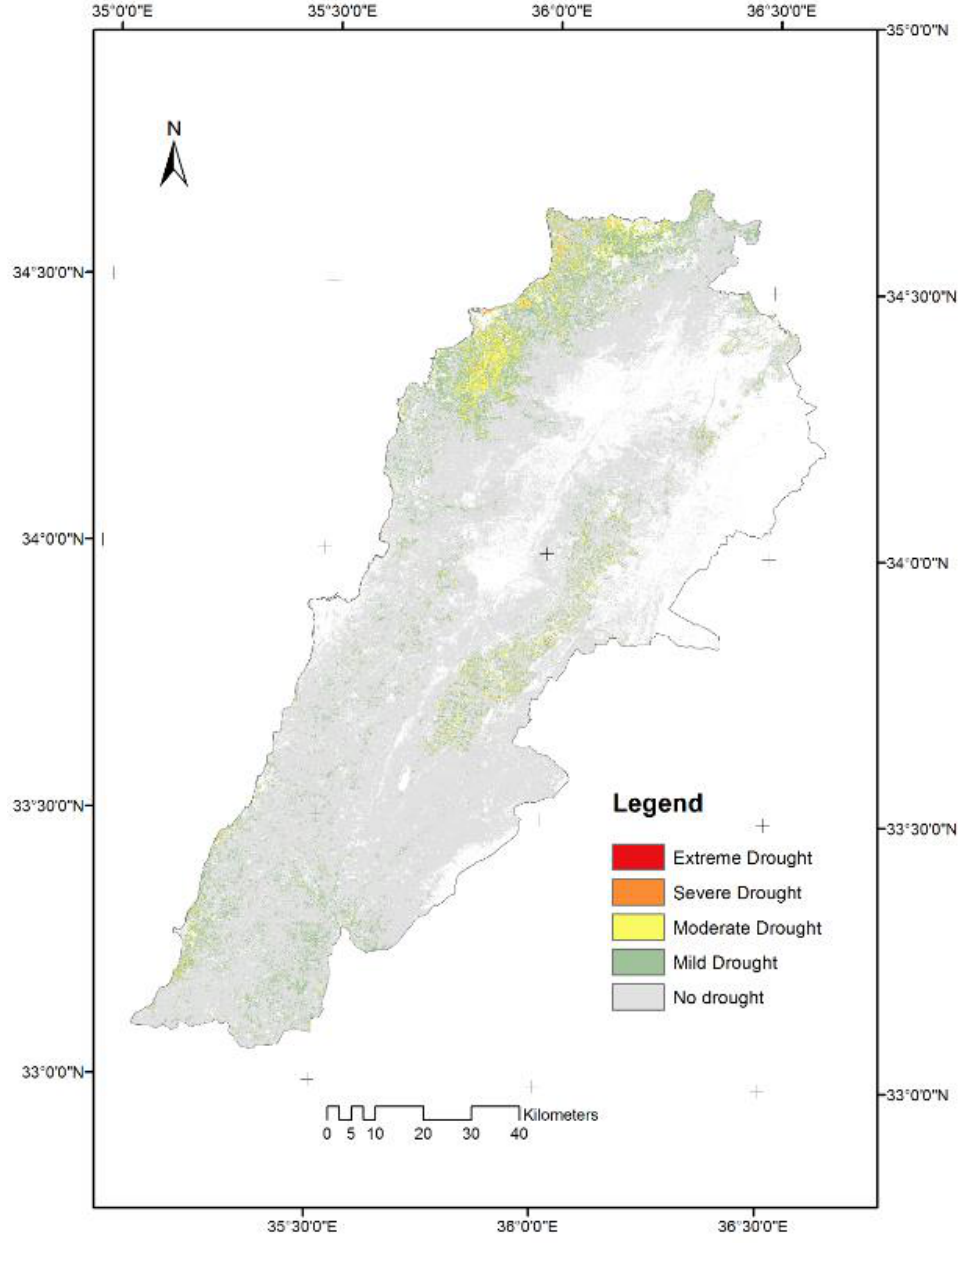
Figure 4. Vegetation Health Index (VHI) classes in Lebanon,